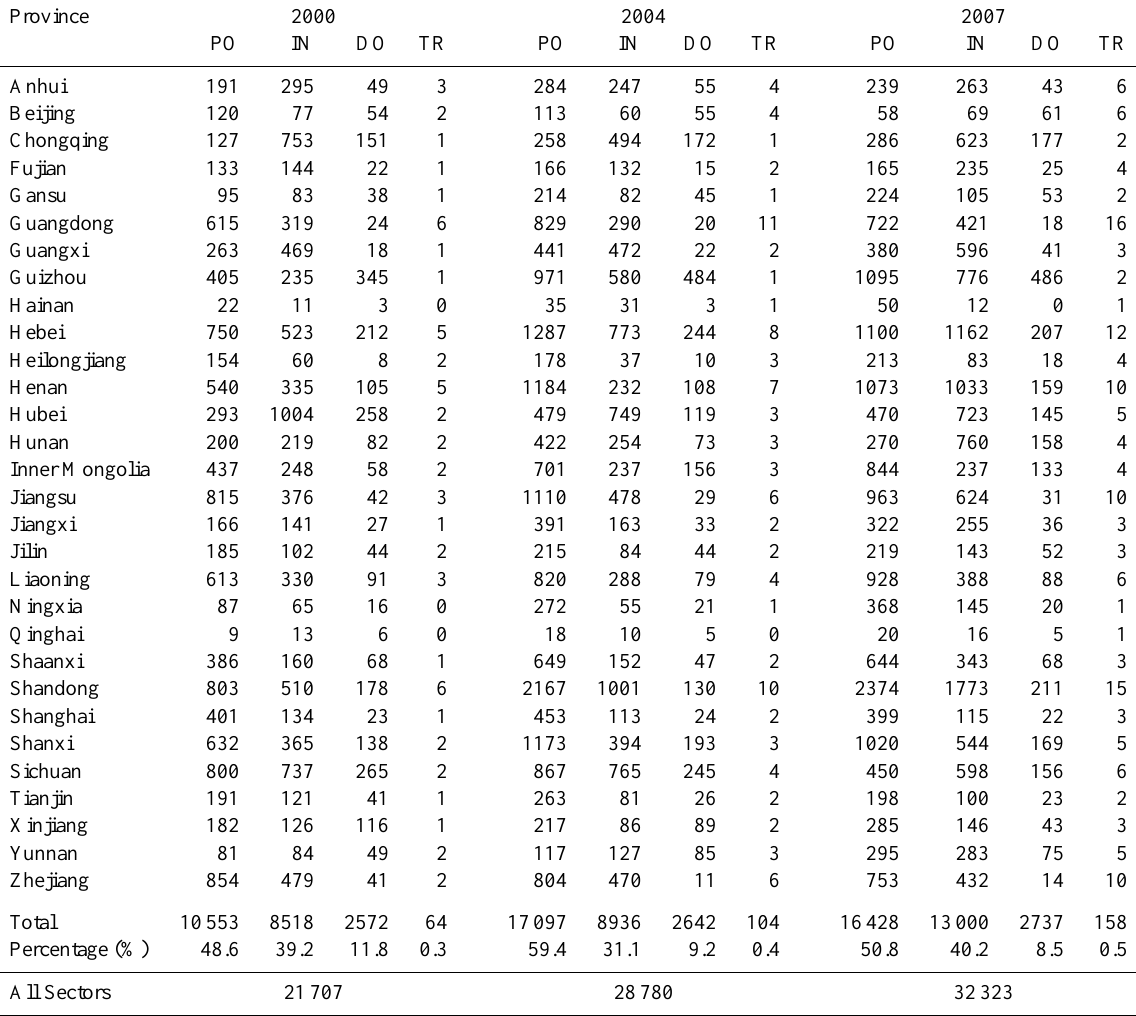
Table 2. SO 2 emission in China by province and by sector in 2000, 2004, and 2007 (unit: Gg/year) a . Province